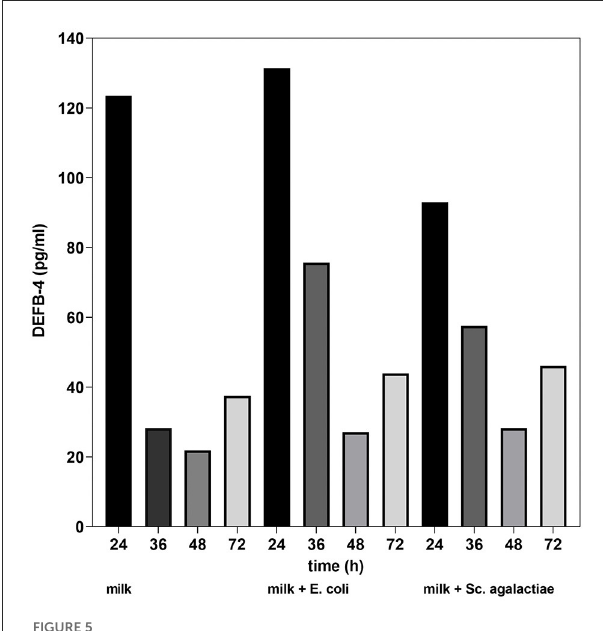
FIGURE5 DEFB-4 concentration in milk as part of the in vitro study. Comparison of untreated milk, milk + E. coli and milk + Sc.